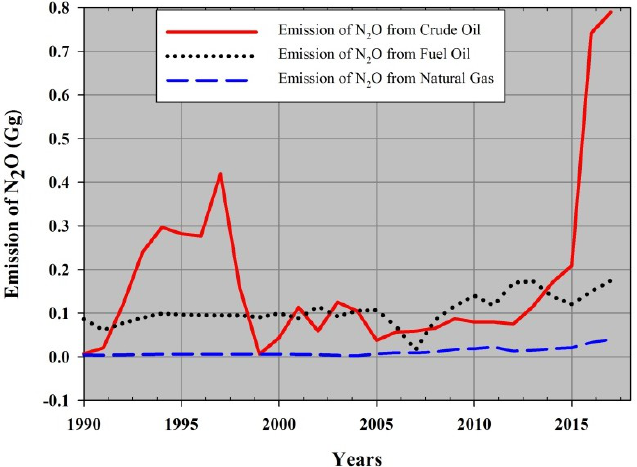
Figure 7. Emissions of N 2 O from the consumption of crude oil, fuel oil, and natural gas in electricity generation from 1990 to 2017.